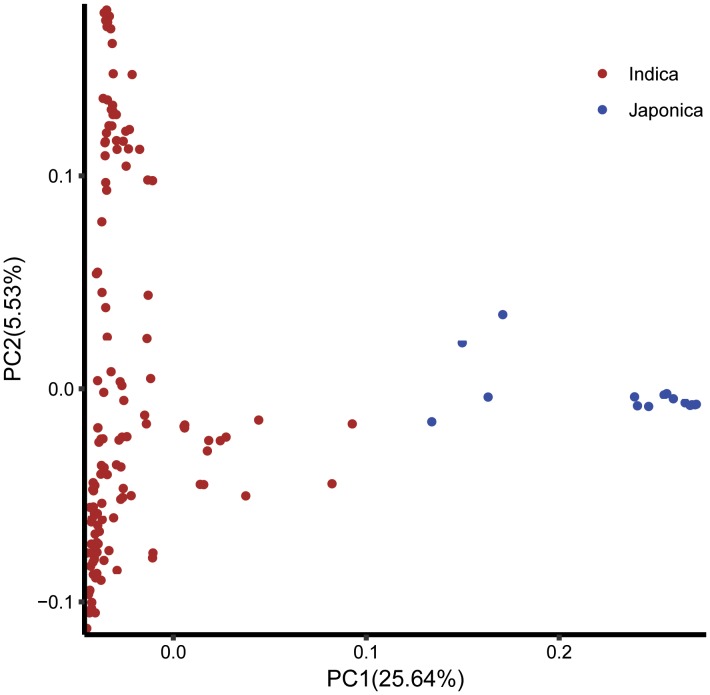
The principal component analysis based on the entire SNP set for the entire core collection. PC1 and PC2 refer to the first and second principal components, respectively. The numbers in parentheses refer to the proportion of variance explained by the corresponding axis.